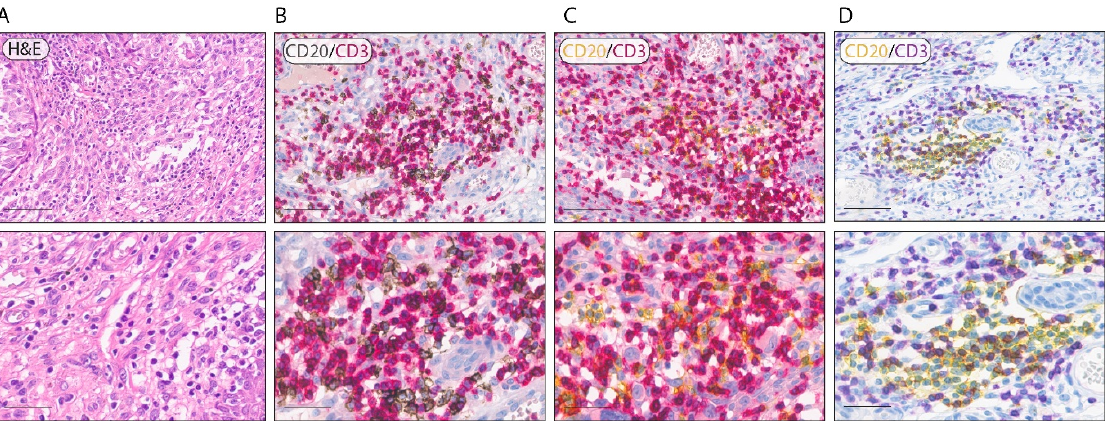
Figure 1. Representative double-labeling BF multiplex IHC of melanoma tissue. ( A ) Representative images of hematoxylin and eosin staining ( B ) Representative image of double CD20/CD3 staining with DAB (CD20) and Red (CD3) chromogens. ( C ) Representative image of double CD20/CD3 staining with Yellow (CD20) and Red (CD3) chromogens. ( D ) Representative image of double CD20/CD3 staining with Yellow (CD20) and Purple (CD3). Magnification: 200× and 400× (scale bar: 100 µm and 50 µm).